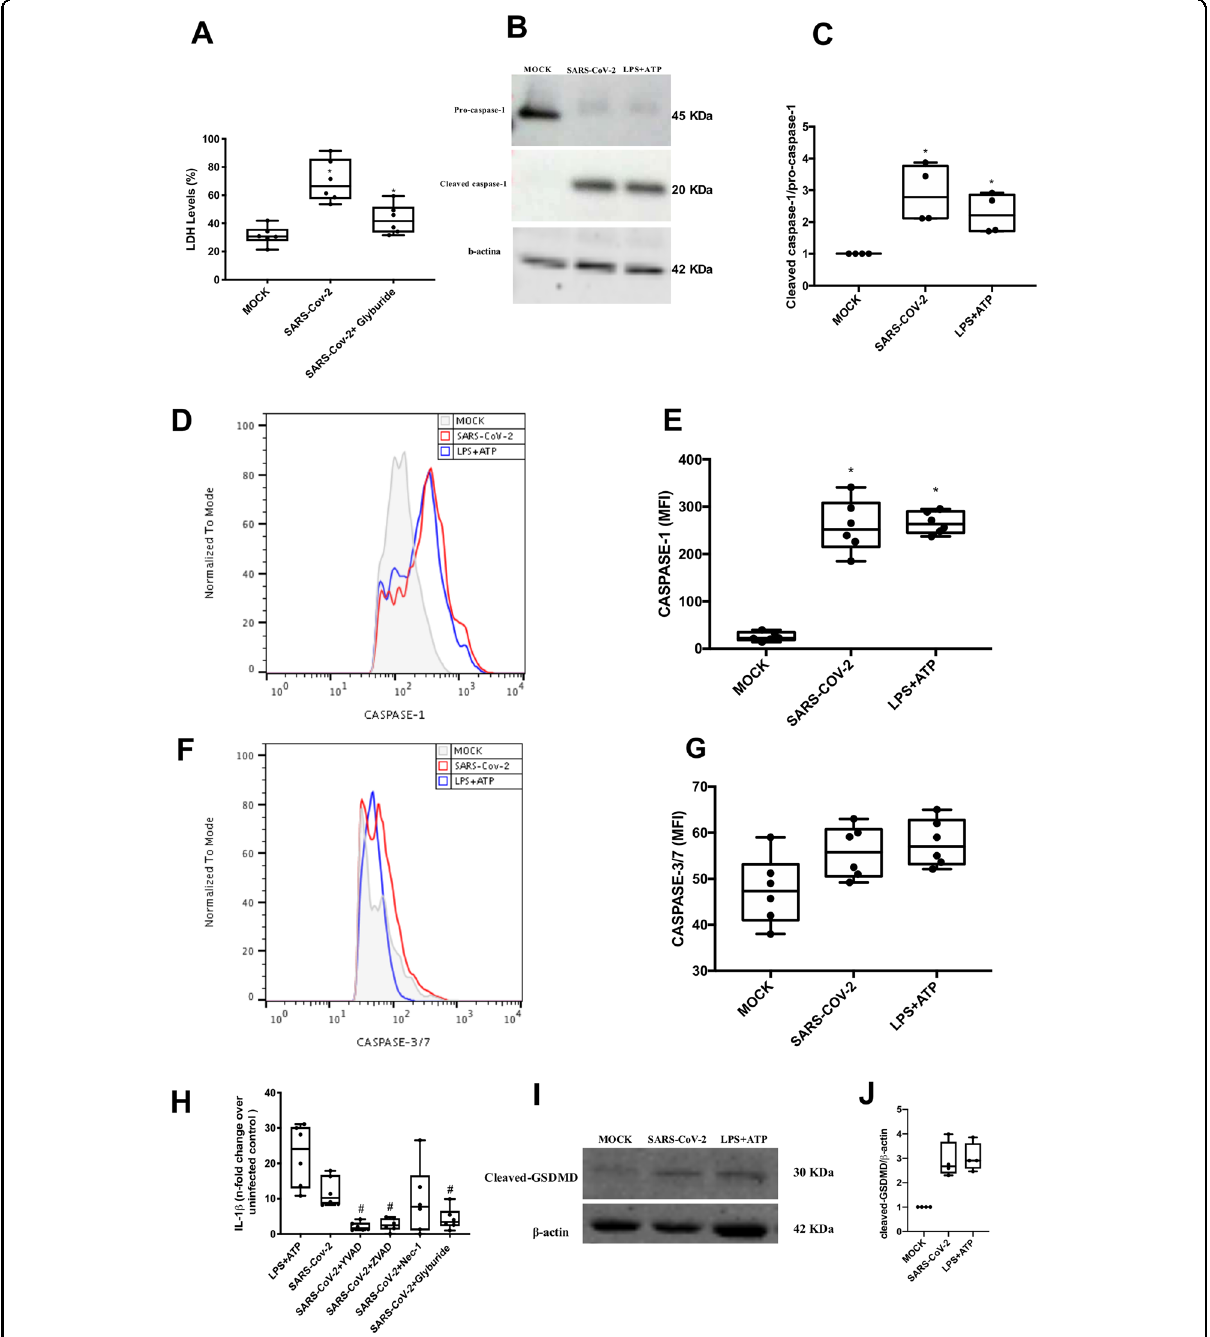
Fig. 2 Lytic cell death in SARS-CoV-2-infected monocytes associates with in fl ammasome engagement and pyroptosis. Human monocytes were treated with pharmacological inhibitors to impair the function of the following proteins: NLPR3 (Gliburyde; 100 µM), caspase-1 (AC-YVAD-CMK; 1 µM), or pan-caspase (Z-VAD-FMK; 10 µM) or RIPK (Nec-1; 25 µM). Monocytes were treated since 1 h prior to infection with SARS-CoV-2 (MOI 0.1), for 24 h. As a control, monocytes were stimulated with LPS (500 ng/mL) for 23 h and, after this time, stimulated with ATP (2 mM) for 1 h. A Cell viability was assessed through the measurement of LDH levels in the supernatant of monocytes. B , C Monocytes were lysed and used for determination of pro-caspase-1 and cleaved caspase-1 levels by western blotting. D , E Monocytes were stained with FAM-YVAD-FLICA to determine the caspase-1 activity by fl ow cytometry. F , G Monocytes were stained with FAM-FLICA to determine caspase-3/7 activity by fl ow cytometry. H Cell culture supernatants were collected for the measurement of the levels of IL-1 β . I , J Monocytes were lysed and cleaved GSDMD levels were determined western blotting. Western blotting images, histogram and graph data are representative of six independent experiments. Data are presented as the mean ± SEM # P < 0.05 versus infected and untreated group; * P < 0.05 versus control group